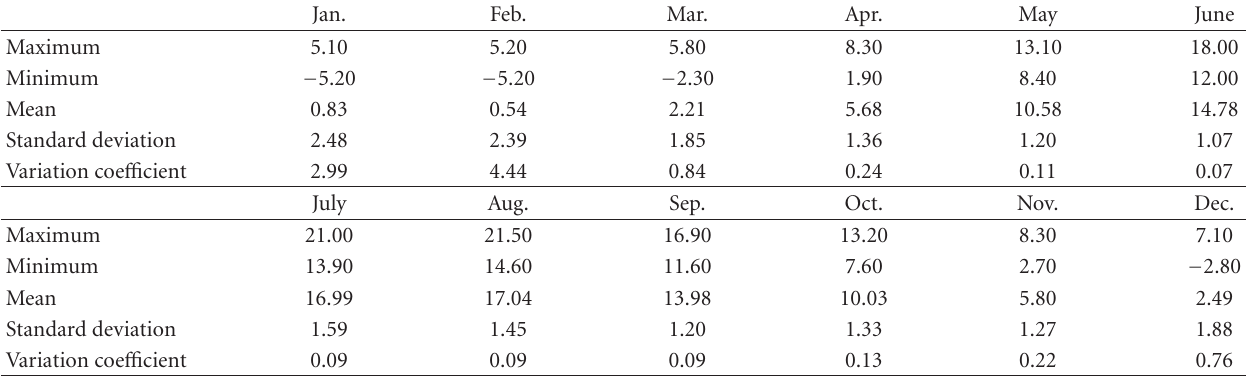
Table 1: Descriptive statistics for monthly average temperature from 1961 to 2010 (unit: ◦ C). Jan. Feb. Mar.